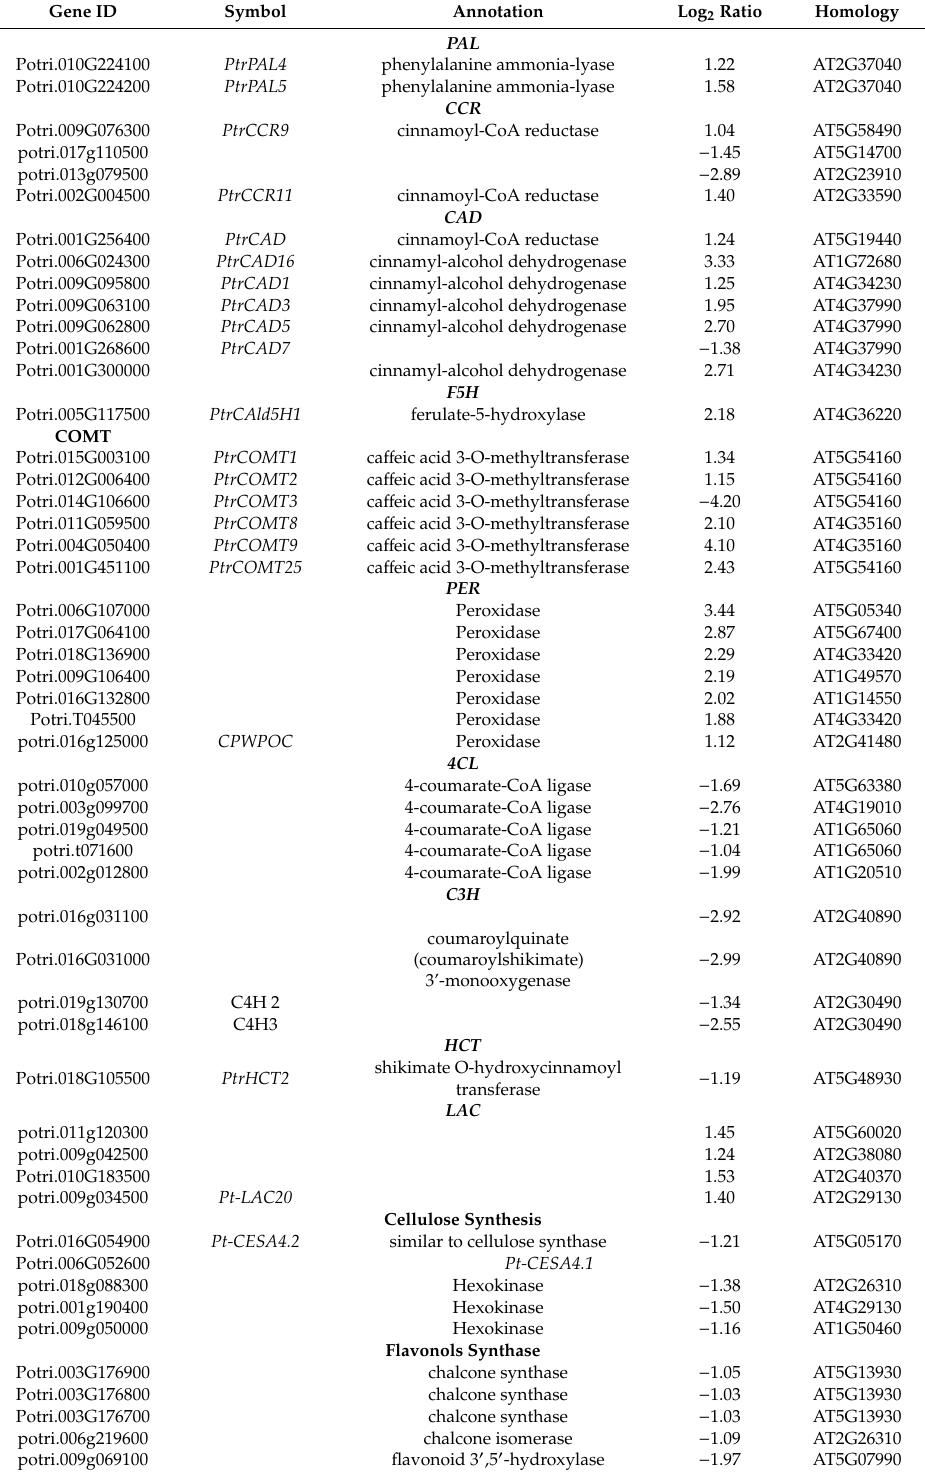
Table 2. Selected significantly di ff erentially expressed genes related to phenylpropanoid biosynthesis and cellulose biosynthesis in roots of “Nanlin895” exposed to boron